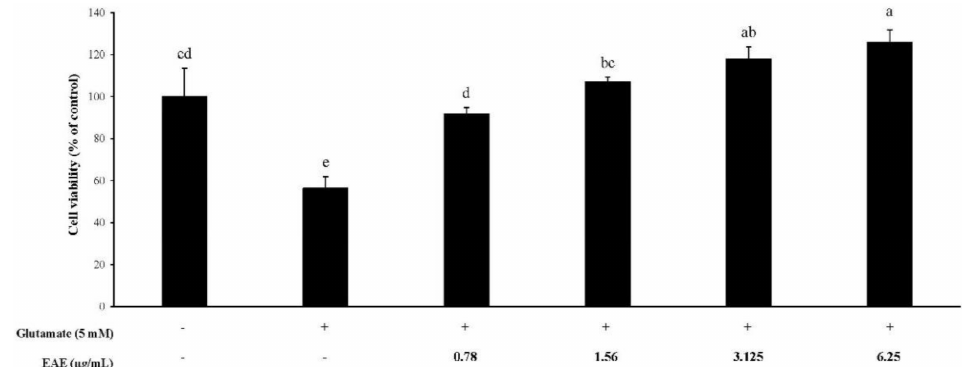
Figure 2. Protective e ff ect of the EAE on glutamate-induced cell growth inhibition in HT22 cells. Results are expressed as mean ± SD ( n = 3). Statistical analysis was performed using a one-way ANOVA, followed by Duncan’s multiple range test. Values not sharing common alphabetical letters (a–d) represent significant di ff erences from each other ( p <